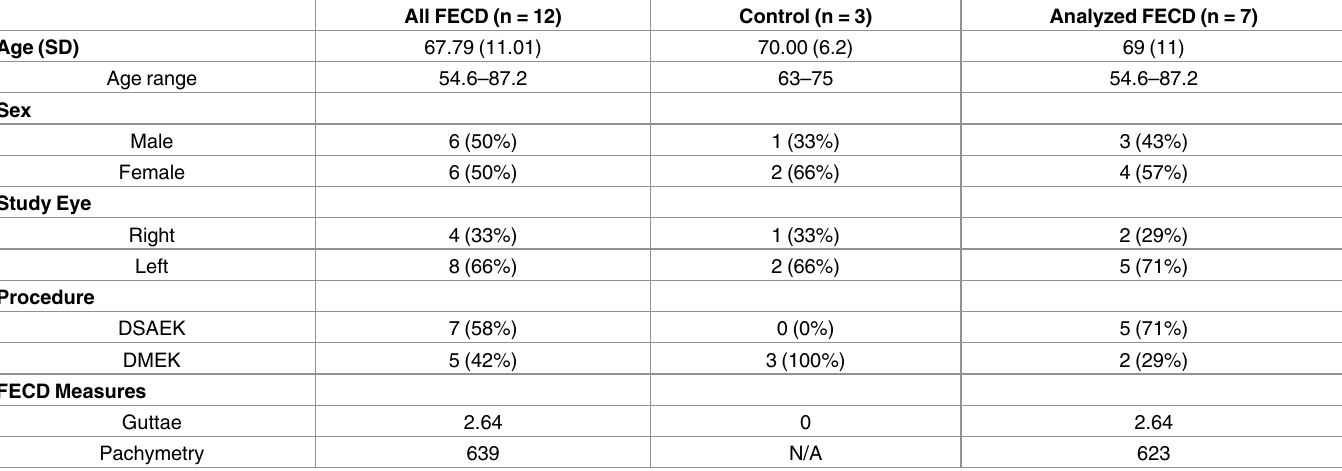
Table 3. Demographics of study participants for MethyLight